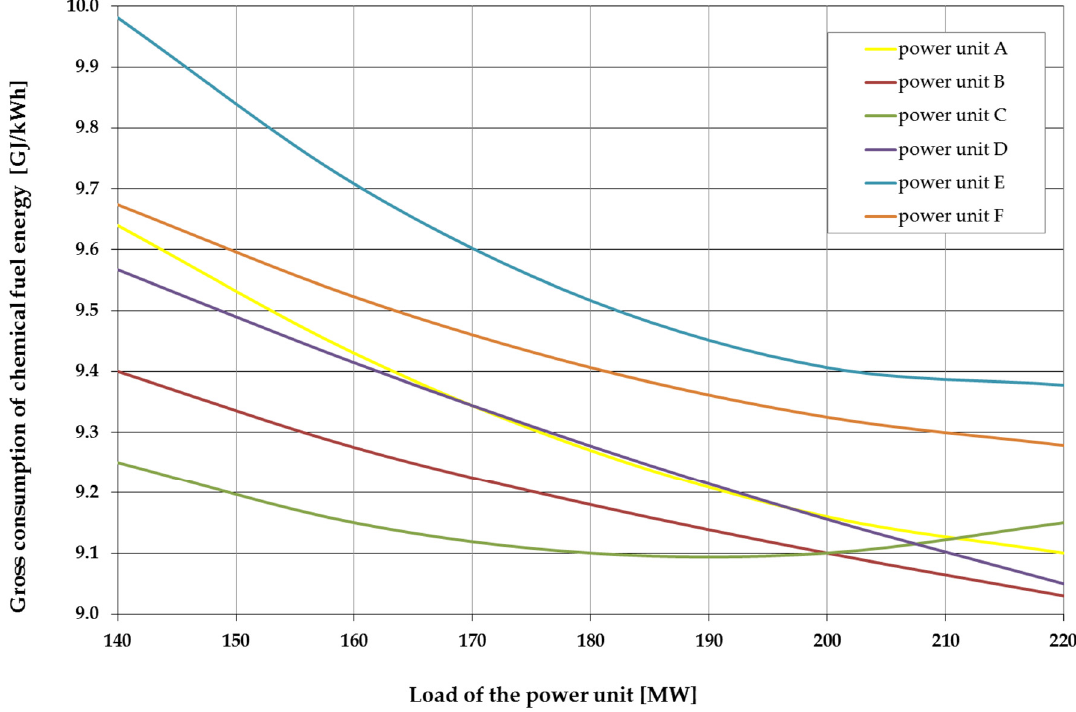
Figure 1. Operational characteristics of the power units of the analyzed coal-fired power plant.